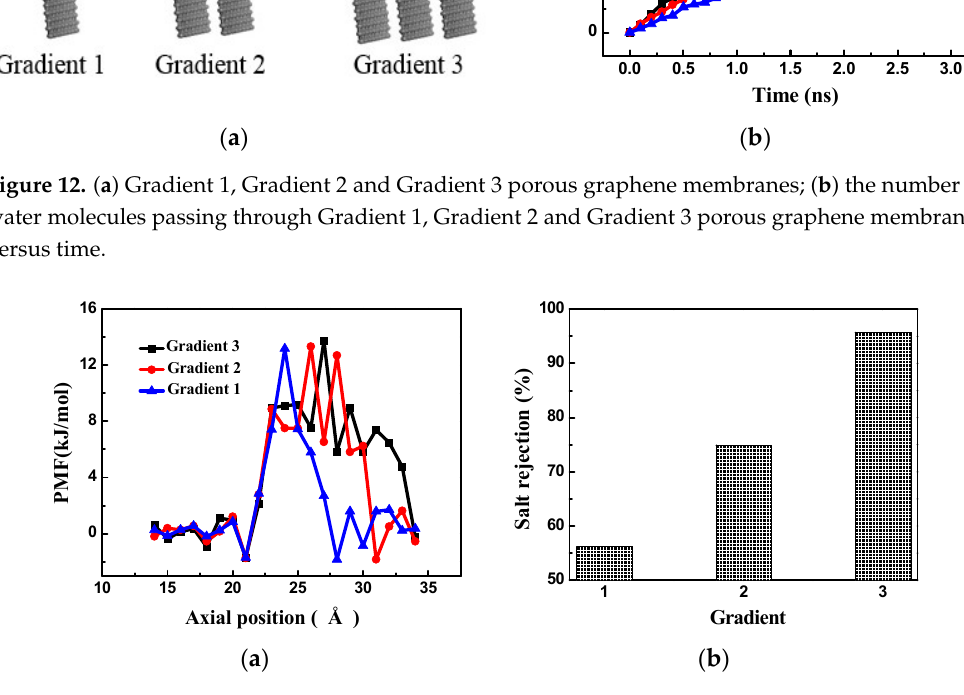
Figure 13. ( a ) The PMF of the porous graphene membranes for Gradient 1, Gradient 2 and Gradient 3;